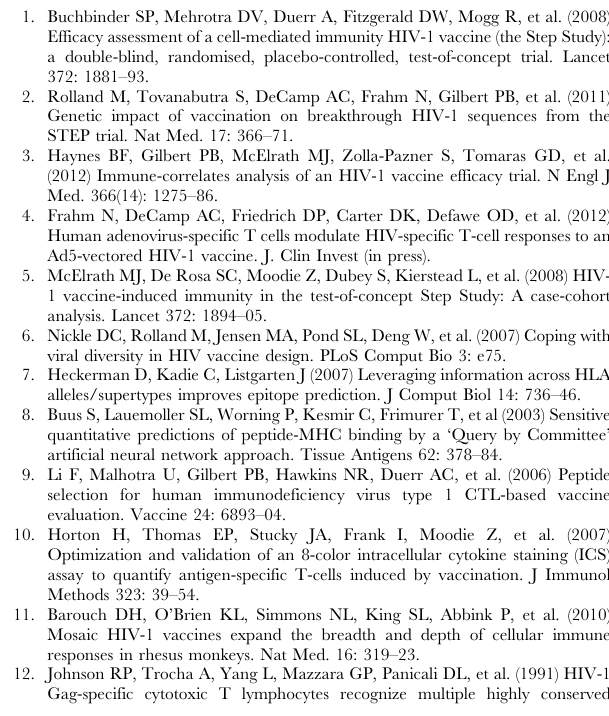
Figure S8 Association Between Acute Log 10 Viral Load and Breakthrough K-mers NetMHC Distance. The breakthrough K- mers distance is the percentage of NetMHC-predicted epitopes in the insert sequence that mismatch at least one breakthrough sequence. Missing viral load values were multiply imputed and represent averages across 20 datasets; solid points are observed values and open points are averages across 20 imputations. The Pearson correlation (r) is shown for vaccine (red circles; dashed line) and placebo (green squares; solid line) groups. Fitted lines from linear regression models are overlaid. Figure S9 Association Between Acute Log 10 Viral Load and Breakthrough K-mers Epipred Distance. The breakthrough K- mers distance is the percentage of Epipred-predicted epitopes in the insert sequence that mismatch at least one breakthrough sequence. Missing viral load values were multiply imputed and represent averages across 20 datasets; solid points are observed values and open points are averages across 20 imputations. The Pearson correlation (r) is shown for vaccine (red circles; dashed line) and placebo (green squares; solid line) groups. Fitted lines from linear regression models are overlaid. Figure S10 Association Between Acute Log 10 Viral Load and Predicted CTL Epitope NetMHC Distance. The predicted CTL epitope distance between a breakthrough sequence and the MRKAd5 insert is the HIV-specific evolutionary (PAM) distance in peptides predicted to be epitopes in both sequences (based on NetMHC), averaged over a subject’s breakthrough sequences. Missing viral load values were multiply imputed and represent averages across 20 datasets; solid points are observed values and open points are averages across 20 imputations. The Pearson correlation (r) is shown for vaccine (red circles; dashed line) and